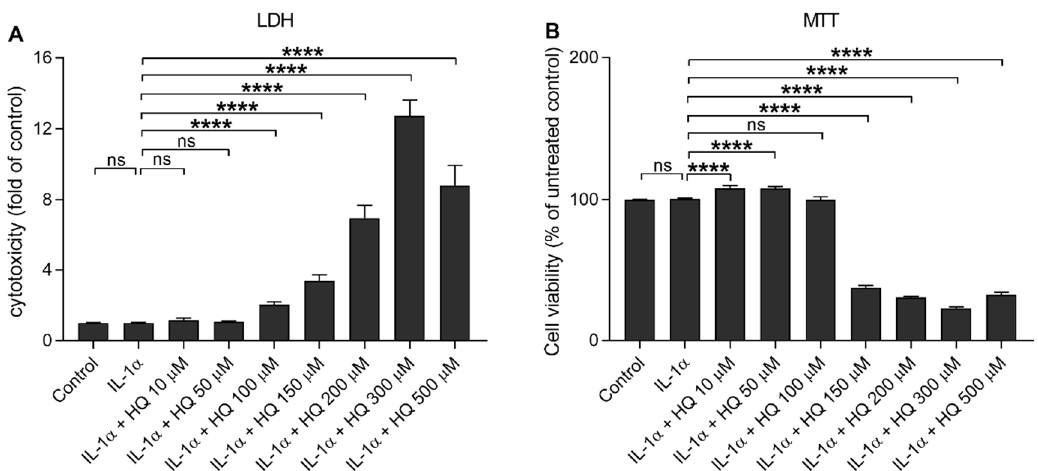
Figure 1. The effect of hydroquinone (HQ 10–500 µ M; 18 h) on the cell viability of IL-1 α -primed ARPE-19 cells measured using the LDH ( A ) and MTT ( B ) assays. Results have been normalized to the mean of the untreated control group. IL-1 α - treated cells served as a control for hydroquinone exposure in primed cells. Data were combined from three independent experiments with four parallel samples per group. Results are shown as mean ± SEM. **** P < 0.0001, ns—not significant, Mann-Whitney U-test. [Kruskal-Wallis test, ( A ) *** P < 0.001, ( B ) *** P < 0.001].